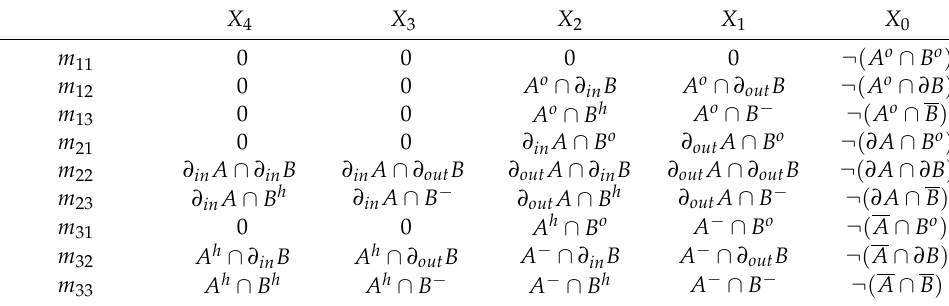
Table A1. Intersecting components in elements of R D 9 IM